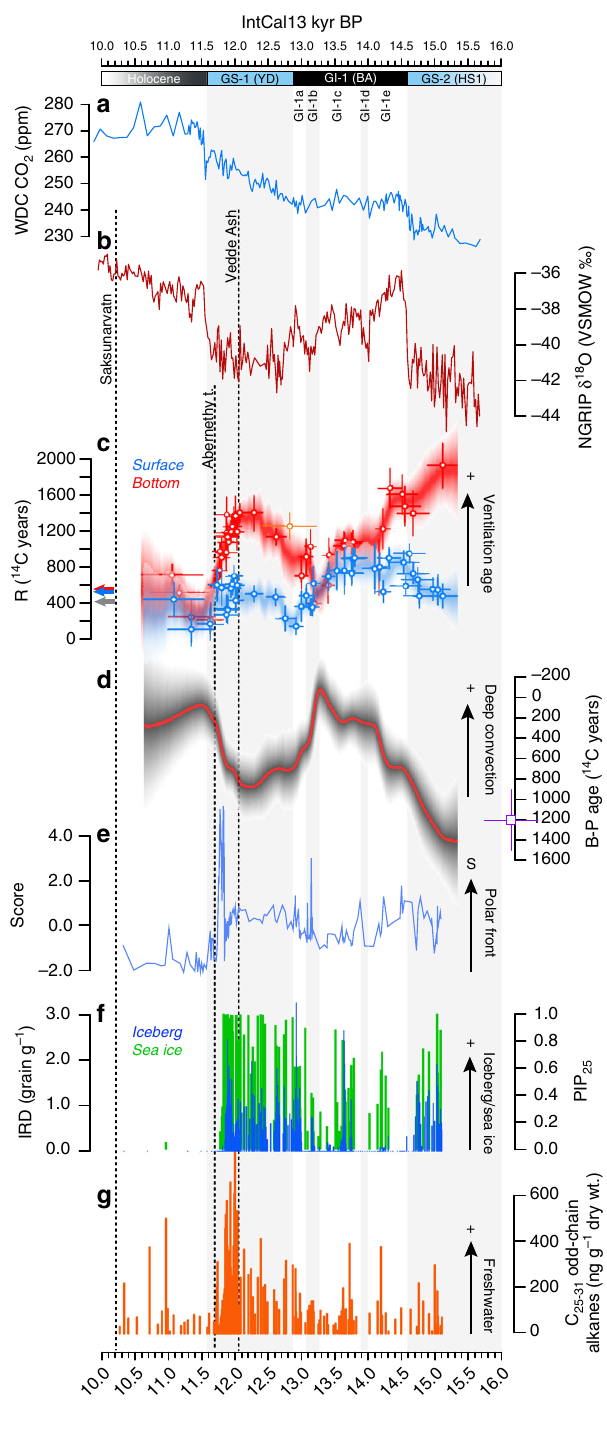
relative to convection sites south of Greenland 18 . The century- scale northward order of NADW re-initiation is consistent with other model results 19 . It is also in line with paleoceanographic 1.0 reconstructions suggesting a delayed resumption of deep con- vection in the high-latitude Nordic Seas starting midway through GI-1 (BA) 20 . Prior to the onset of GS-1 (12870 ± 26 years BP), which corresponds to the Younger Dryas stadial (YD), the B-P age offset rapidly increased by ∼ 900 years starting at 13,250 years BP. Ahead of the termination of GS-1 (11577 ± 16 years BP), the B-P offset returned to modern values beginning at 11,890 years BP (Figs. 2d – 3). GS-1 (YD) onset and termination are also preceded by surface oceanographic changes inferred from sedimentological and lipid biomarker signatures in MD99-2284. Speci fi cally, increasing (decreasing) B-P ages are virtually synchronous with a southward (northward) migration of the polar front across the coring site inferred from faunal assemblages (Fig. 2e; Supplemen- tary Fig. 10), relatively more (less) frequent sea-ice edge conditions inferred from PIP 25 (Methods) and iceberg rafting inferred from IRD (Fig. 2f), and relatively higher (lower) inputs of terrestrial meltwater inferred from sedimentary n -alkane concentrations (Methods; Fig. 2g), ultimately pointing at a tight link between freshwater dynamics and bottom-water ventilation. Although the benthic-atmosphere (B-Atm) offset dominates the B-P signal, the P-Atm offset also decreased prior to the onset of GS-1 (YD) and in phase with the rise in B-P values (Fig. 2c, d). Speci fi cally, P-Atm values slowly declined by ∼ 500 years starting ∼ 13,250 years BP and approached the age of the contemporaneous atmosphere by ∼ 12900 years BP, suggesting that the climatic transition into GS-1 (YD) was preceded by a major slowdown of the Atlantic In fl ow